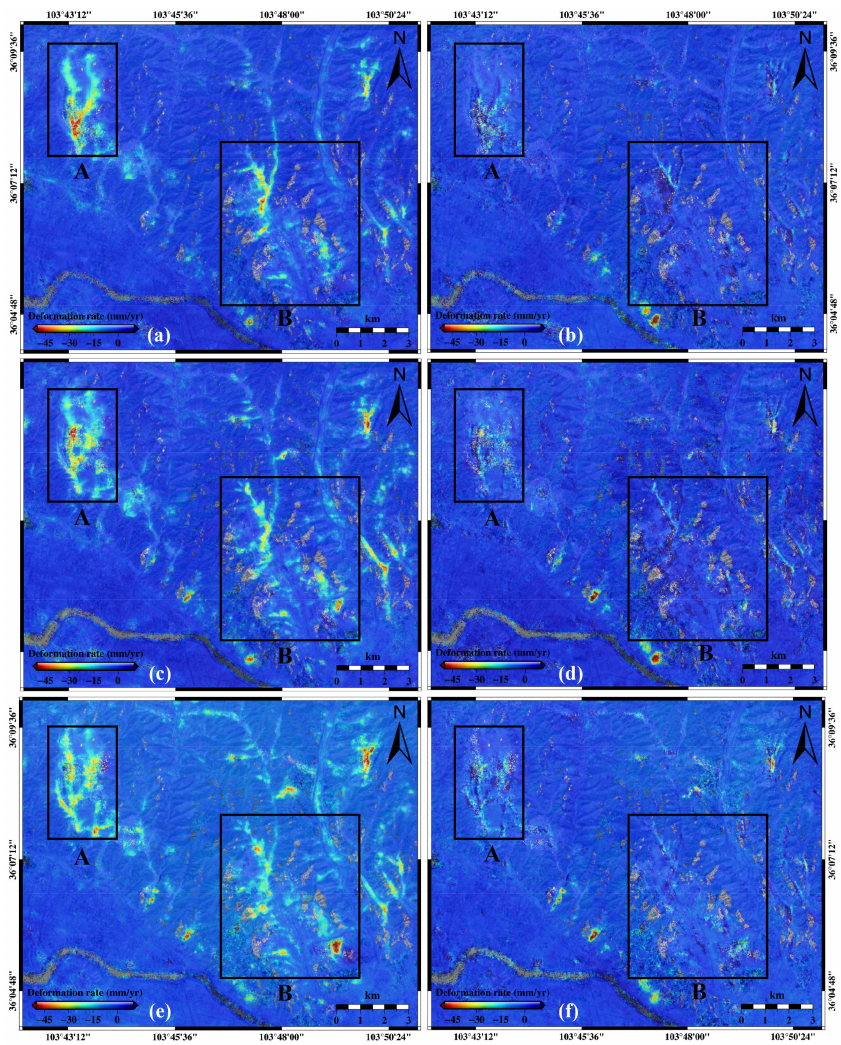
Figure 12. Two-dimensional displacement rates in the vertical (left) and east–west (right) directions of Regions A and B (marked in Figure 11) from December 2015 to March 2021, derived from ascending and descending Sentinel-1 images: ( a , b ) are the vertical and east–west displacement rates between December 2015 and December 2017, respectively; ( c , d ) are the vertical and east–west displacement rates between December 2017 and December 2019, respectively; ( e , f ) are the vertical and east–west displacement rates between December 2019 and March 2021,